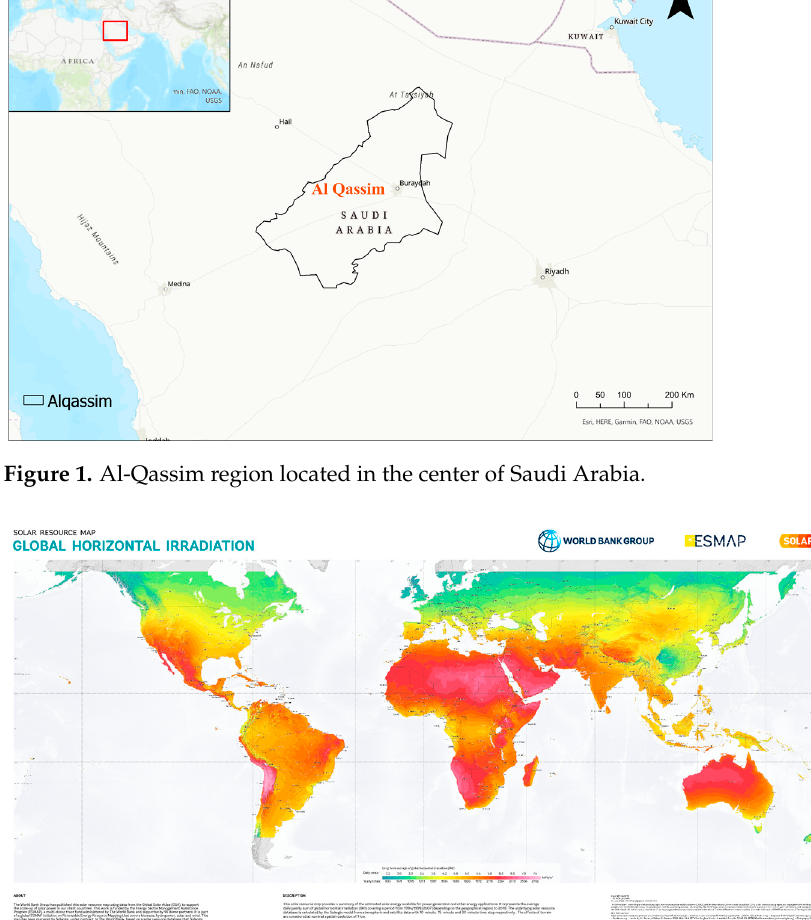
Table 2. Thematic layer datasets used in the geospatial analysis model.